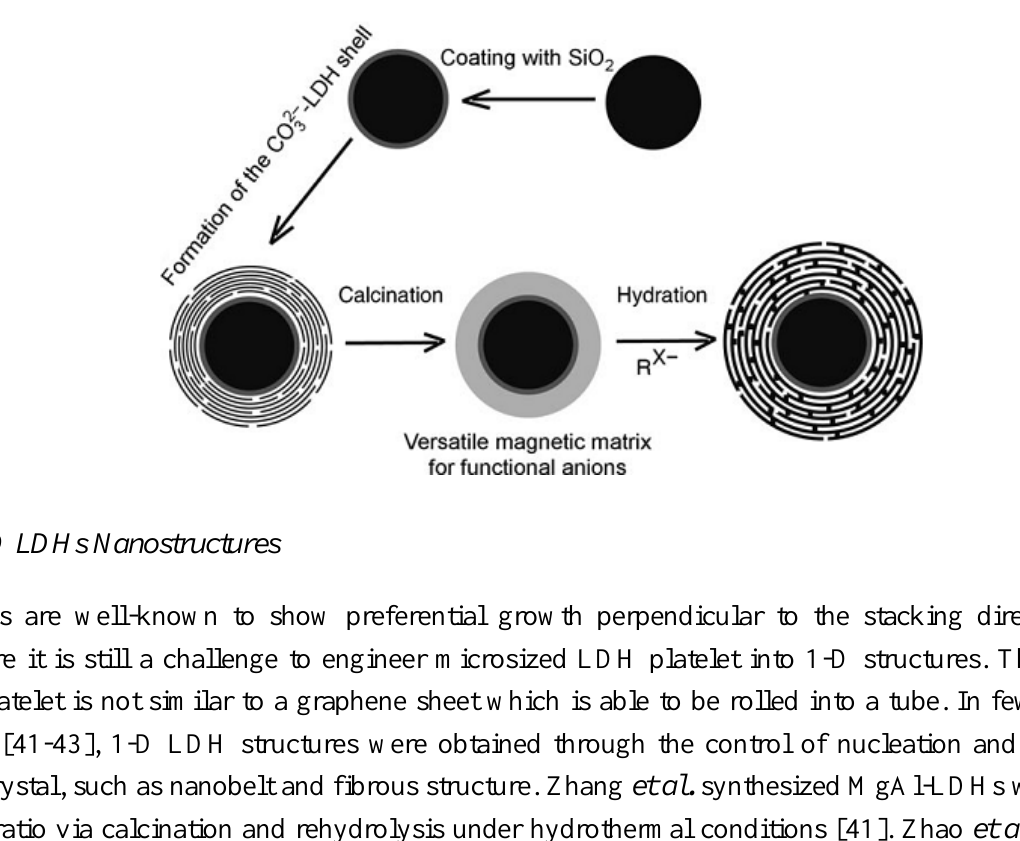
O core/LDH shell composite structure. Reprinted 3 4